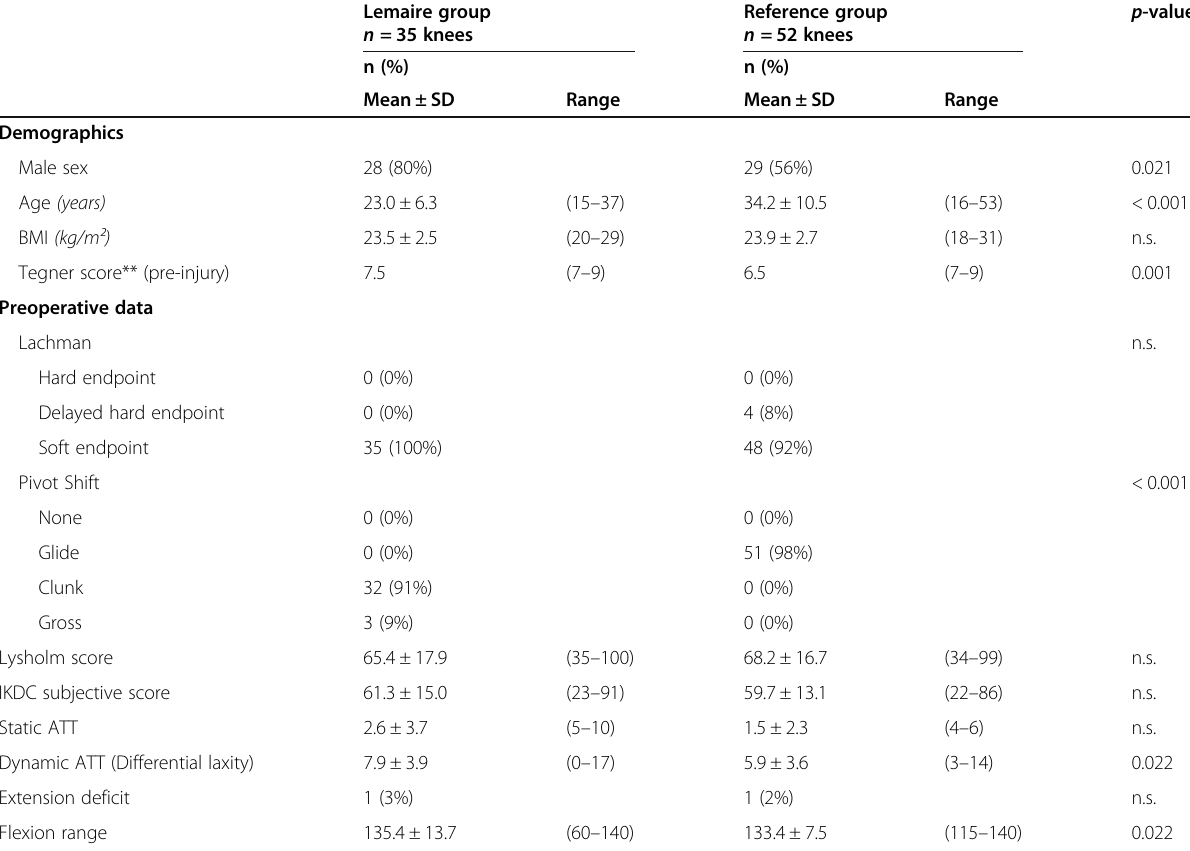
Table 1 Demographics and preoperative data